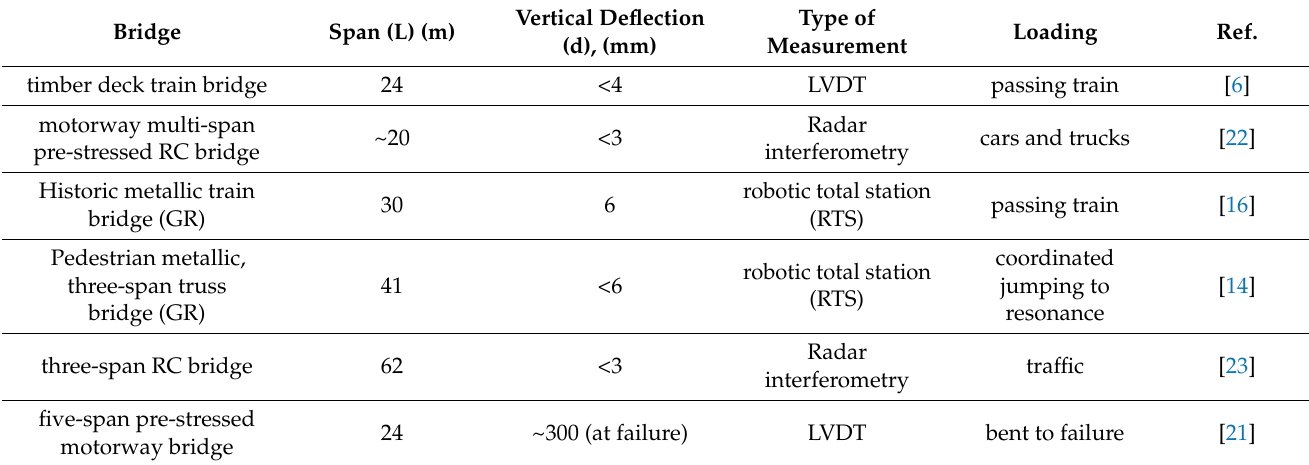
Table 1. Deflection measurements of stiff bridges (not based on